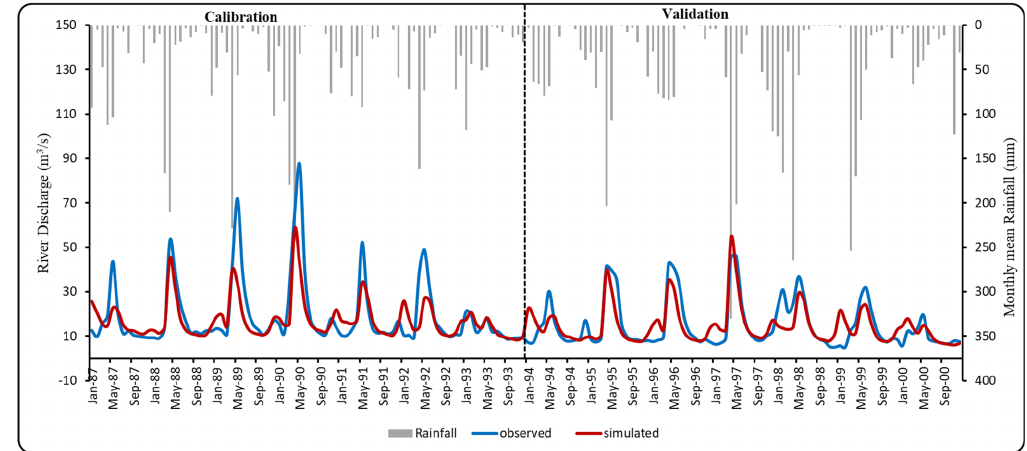
Figure 6. Comparison between the simulated and observed monthly discharge of KWK watershed.